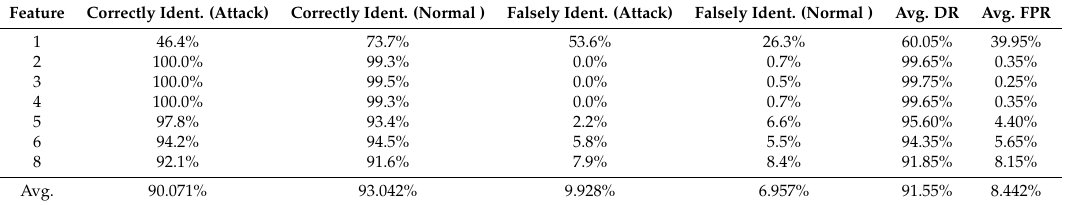
Table 5. Performance of Features using a Hybrid Approach on features in Table